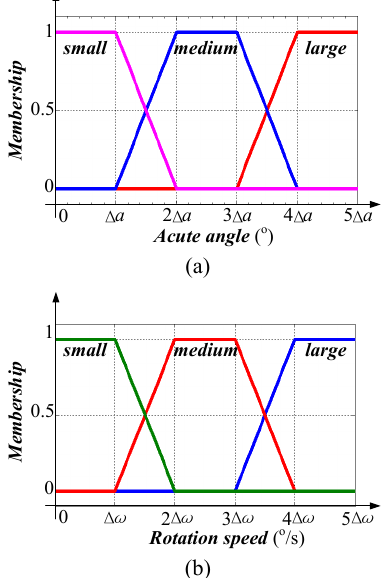
Fig. 8. Diagram of Membership function of rotation. (a) Acute angle/input membership function. (b) Rotational speed/output membership